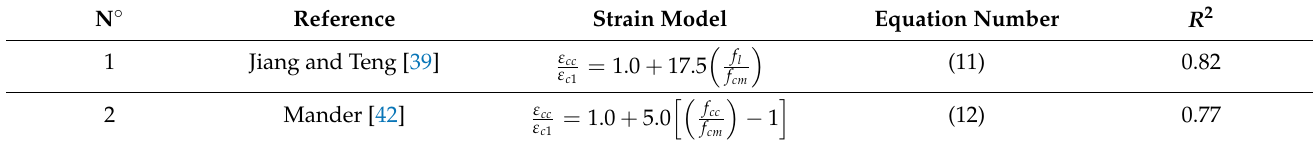
Table 5. Ultimate strain